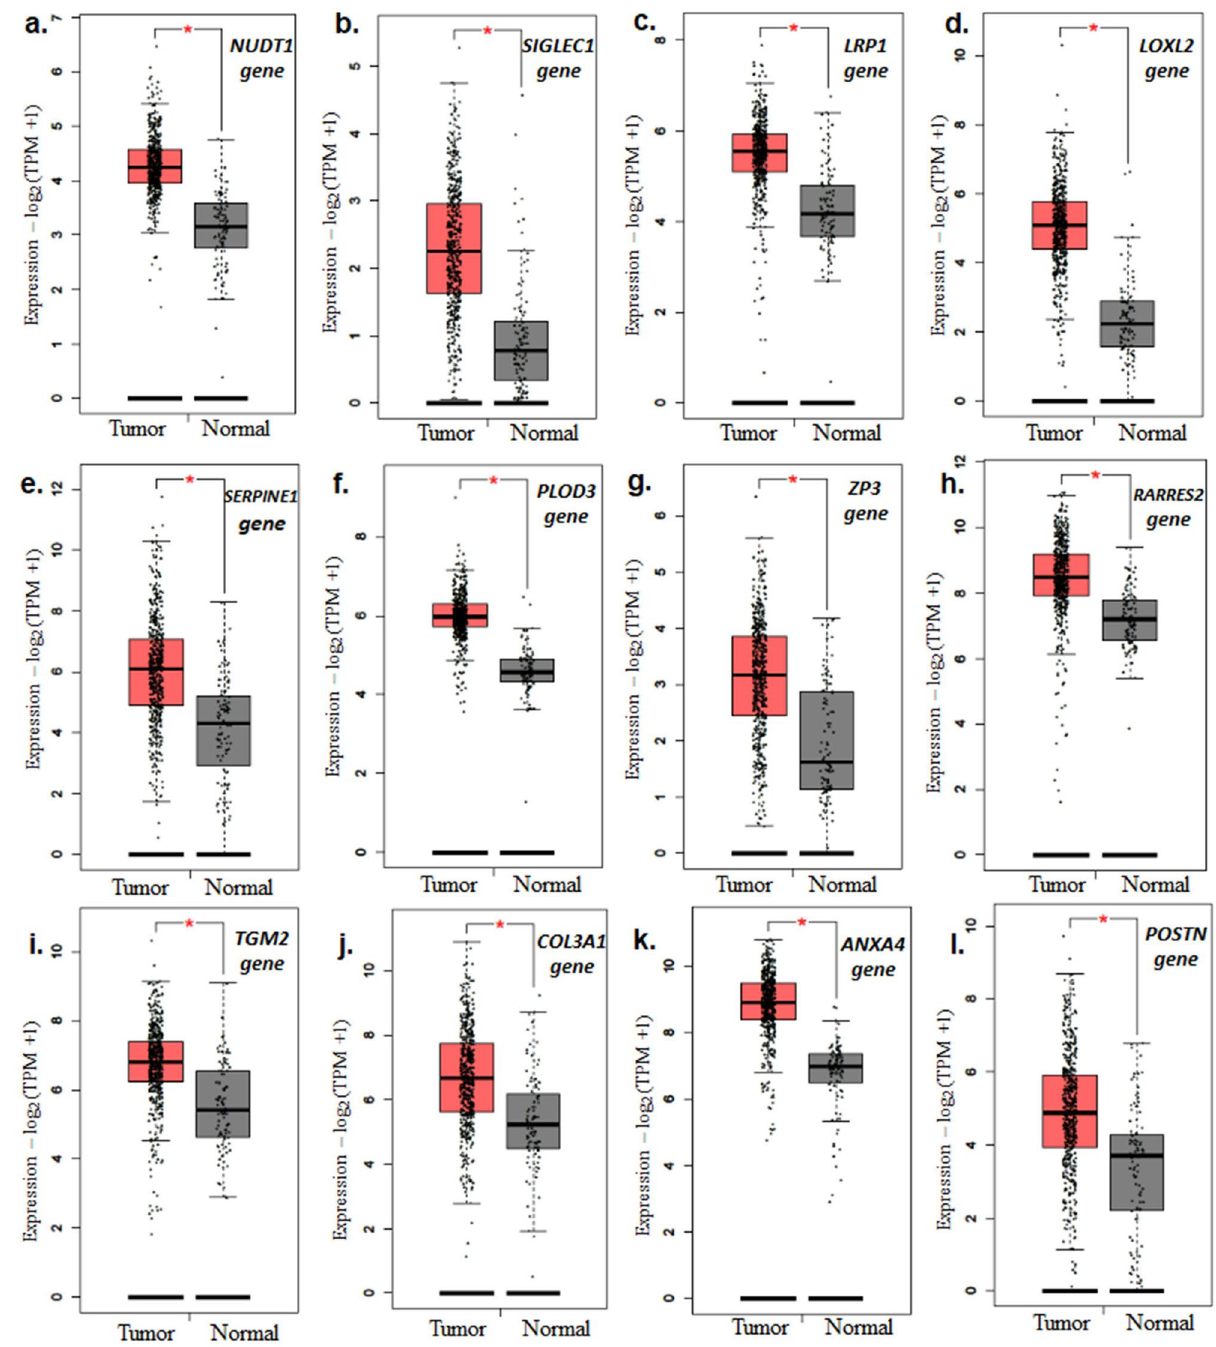
Figure 2. 12 genes with higher expression in tumor (523 patients) compared to normal tissue (100 tissue). ( a ) NUDT1 , ( b ) SIGLEC1 , ( c ) LRP1 , ( d ) LOXL2 , ( e ) SERPINE1 , ( f ) PLOD3 , ( g ) ZP3 , ( h ) RARRES2 , ( i ) TGM2 , ( j ) COL3A1 , ( k ) ANXA4 , and ( l ) POSTN